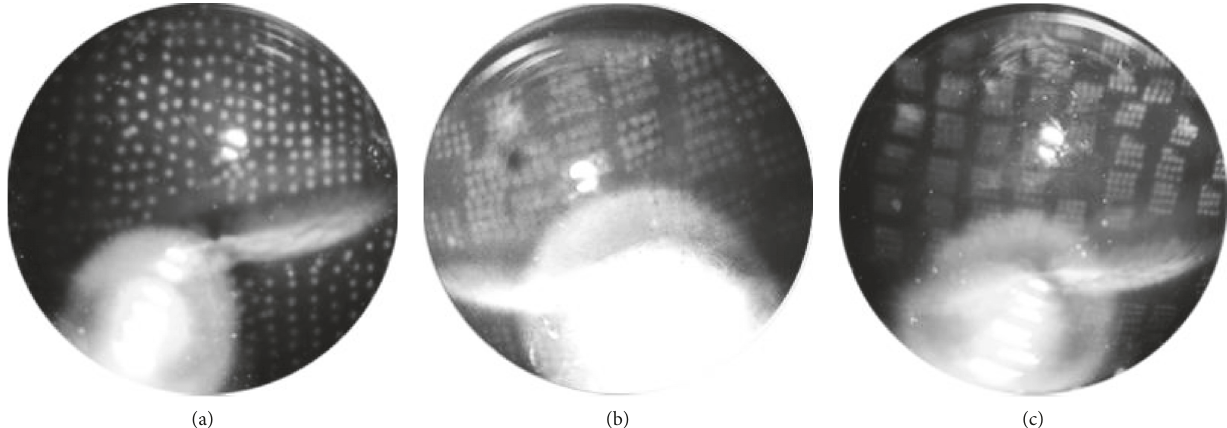
Figure 3: Fundus photography of the eye of a rabbit immediately after retinal laser photocoagulation. (a) 500 spots applied by the conventional argon laser. (b) 500 spots applied by short-pulse laser (SPL). (c) 1000 spots applied by